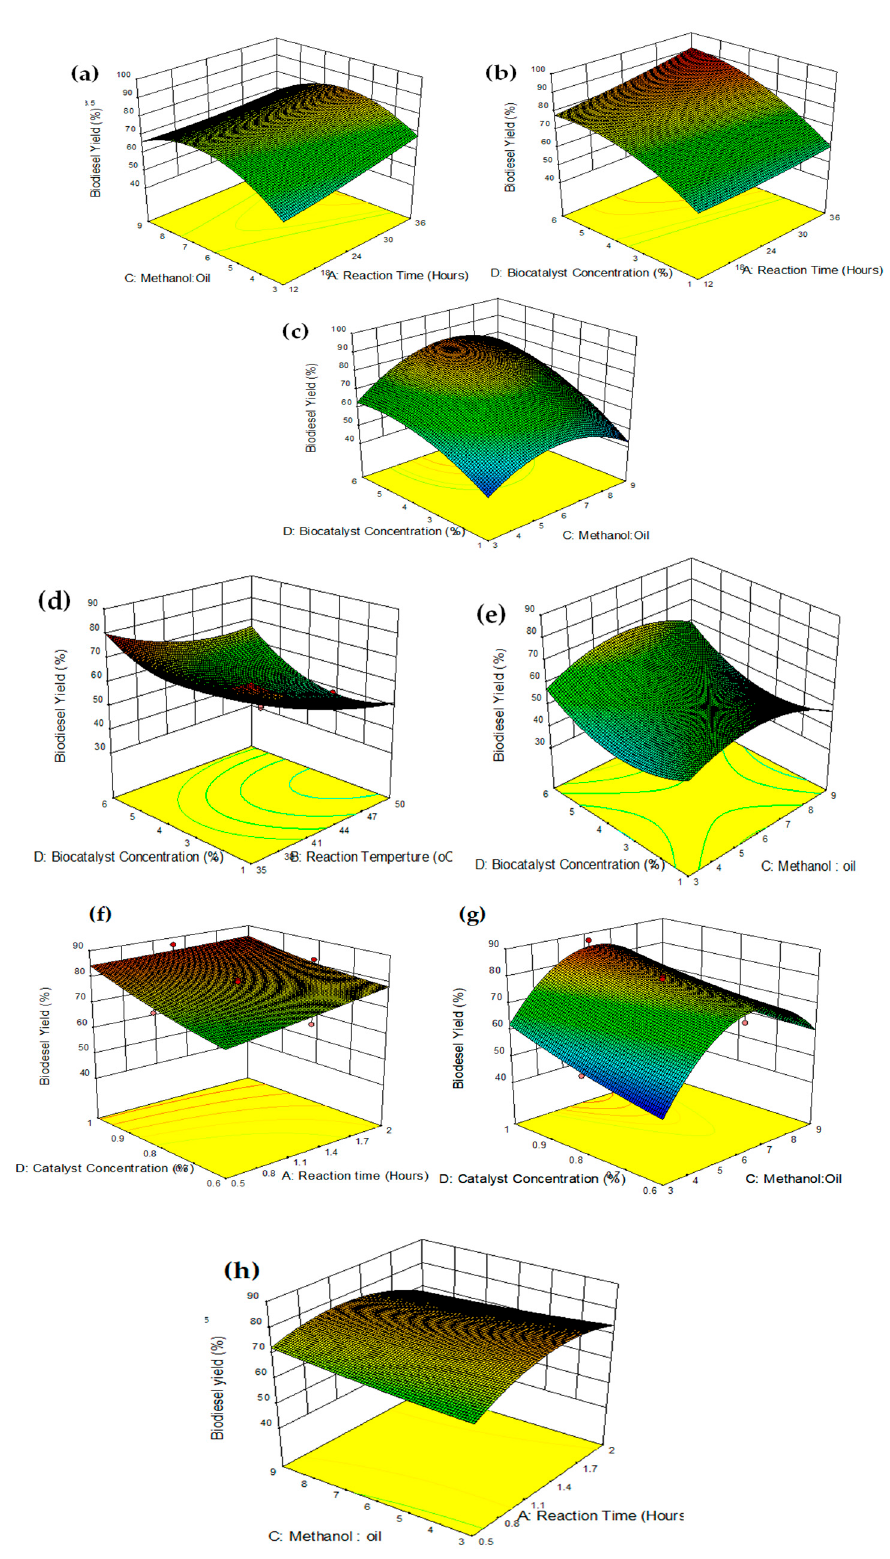
Figure 2. Response surface graphs for the significant 1st order interaction terms of Model a (A × C), b (A × D), c (C × D); Model (b), d (B × D) , e (C × D); Model (c), f (A × D) , g (C × D); Model (d), h (A × C).